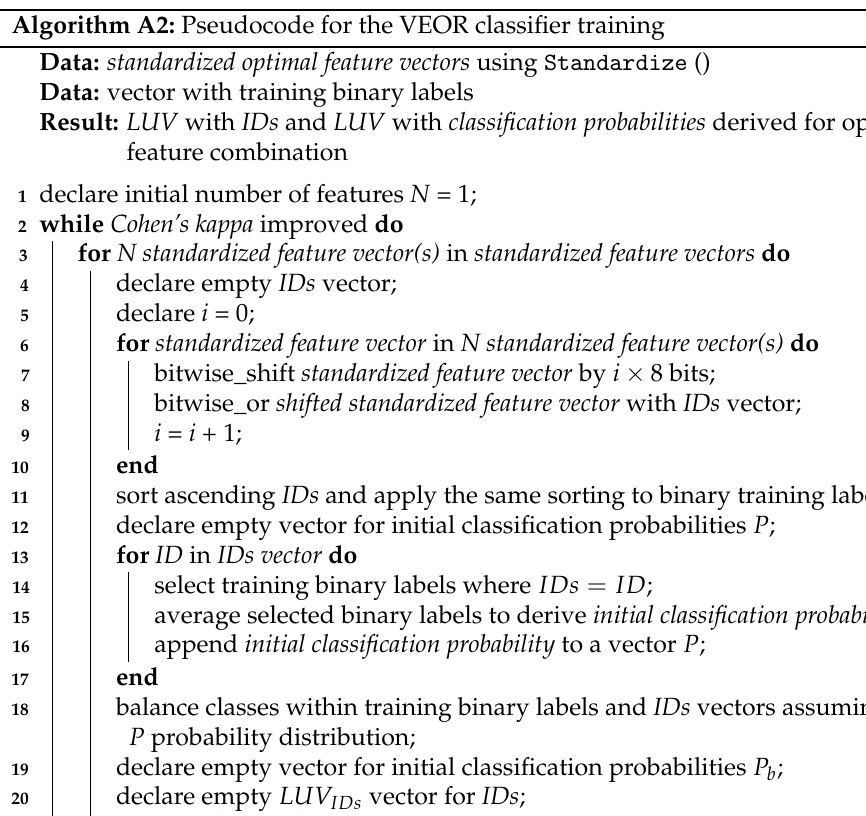
Algorithm A2: Pseudocode for the VEOR classifier